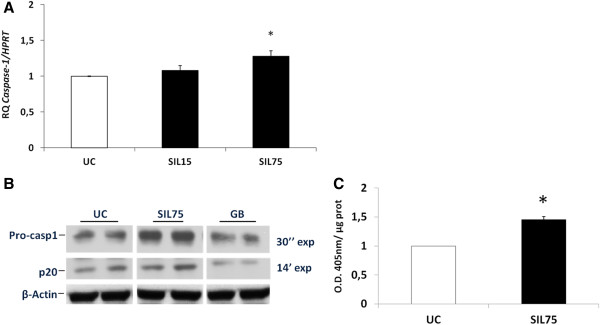
Cristobalite silica increases caspase-1 transcript levels and caspase -1 cleavage products in primary human bronchial epithelial cells. A. Caspase-1 mRNA levels in primary normal human bronchial epithelial (NHBE) cells after 24 h exposure to 15 (SIL15) and 75 × 106μm2/cm2 (SIL75) cristobalite silica, expressed as mean fold change ± SEM (indicated by error bars) with *p-value <0.05 compared to unexposed control cells (UC) and normalized to the housekeeping gene HPRT (N= 3). B. Western blot analysis of caspase-1 cleaved products was conducted on whole cell lysates of NHBE cells after 24 h of exposure. p20 subunits were detected after a longer exposure compared to pro-caspase-1 (14 min versus 30 s). Glass beads (GB) and unexposed cells (UC) were included as controls, and β-actin was used as a loading control. C, Caspase-1 enzymatic activity was assayed in cell lysates of NHBE cells exposed to the indicated silica concentrations for 24 h with. Caspase-1 activities are expressed as arbitrary units (O.D. 405 nm/μg protein) with *p-value <0.05 compared to UC.